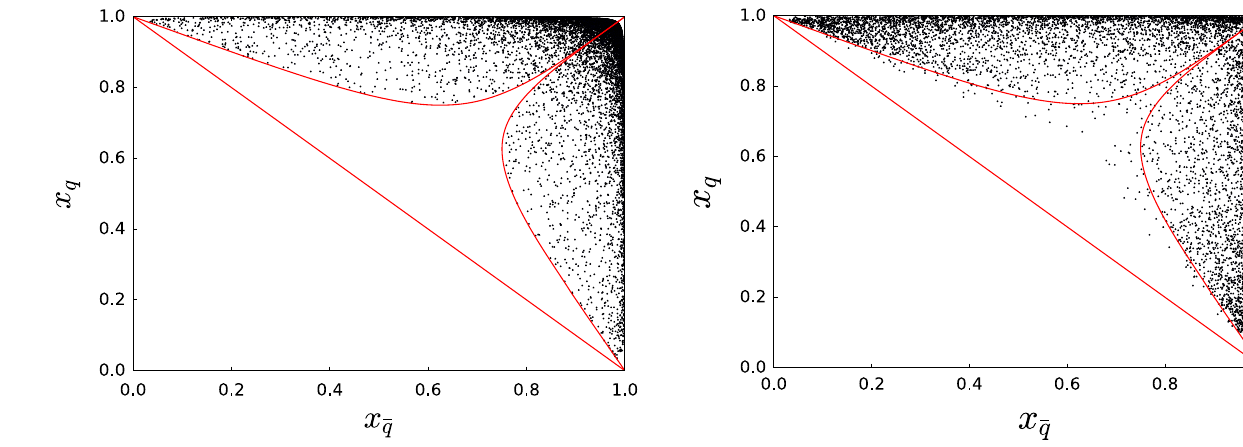
Fig. 4 Dalitz plot for e + e − → q ¯ q showing the region of phase space filled after multiple emission from the quark and antiquark in the angular-ordered parton shower. The transverse momentum of the branchings was preserved in the case of multiple emission. The line shows the limits for the parton-shower emission for a single emission. x i = 2 E i / Q where E i is the energy of parton i and Q is the centre-of- mass energy of the collision